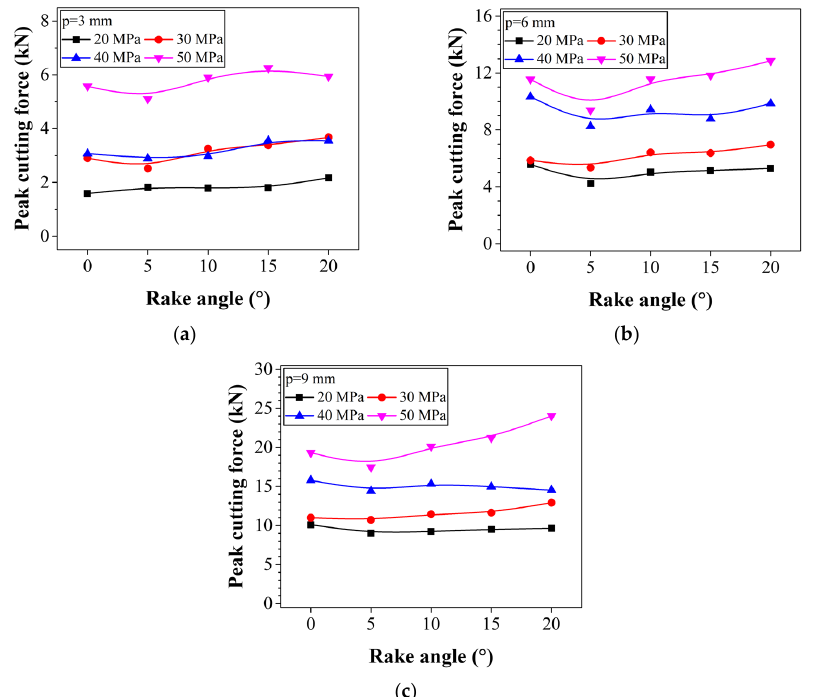
Figure 12. Relationship between the peak cutting force and rake angle for depths ( p ) of: ( a ) 3 mm, ( b ) 6 mm, and ( c ) 9 mm. Table 4. Mean and peak cutting forces for various rake angles.